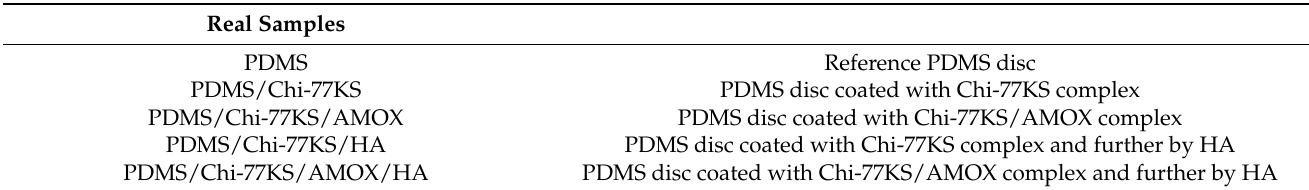
Table 2. Real sample abbreviations with